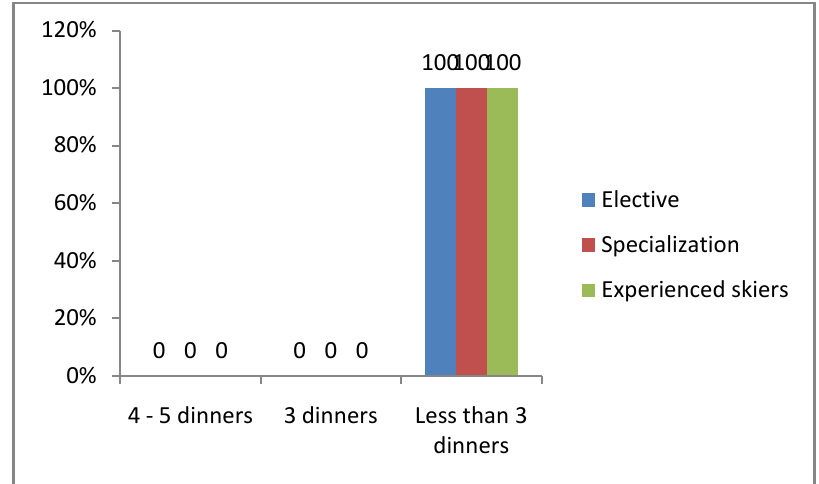
Figure 5. Daily intake of seafood